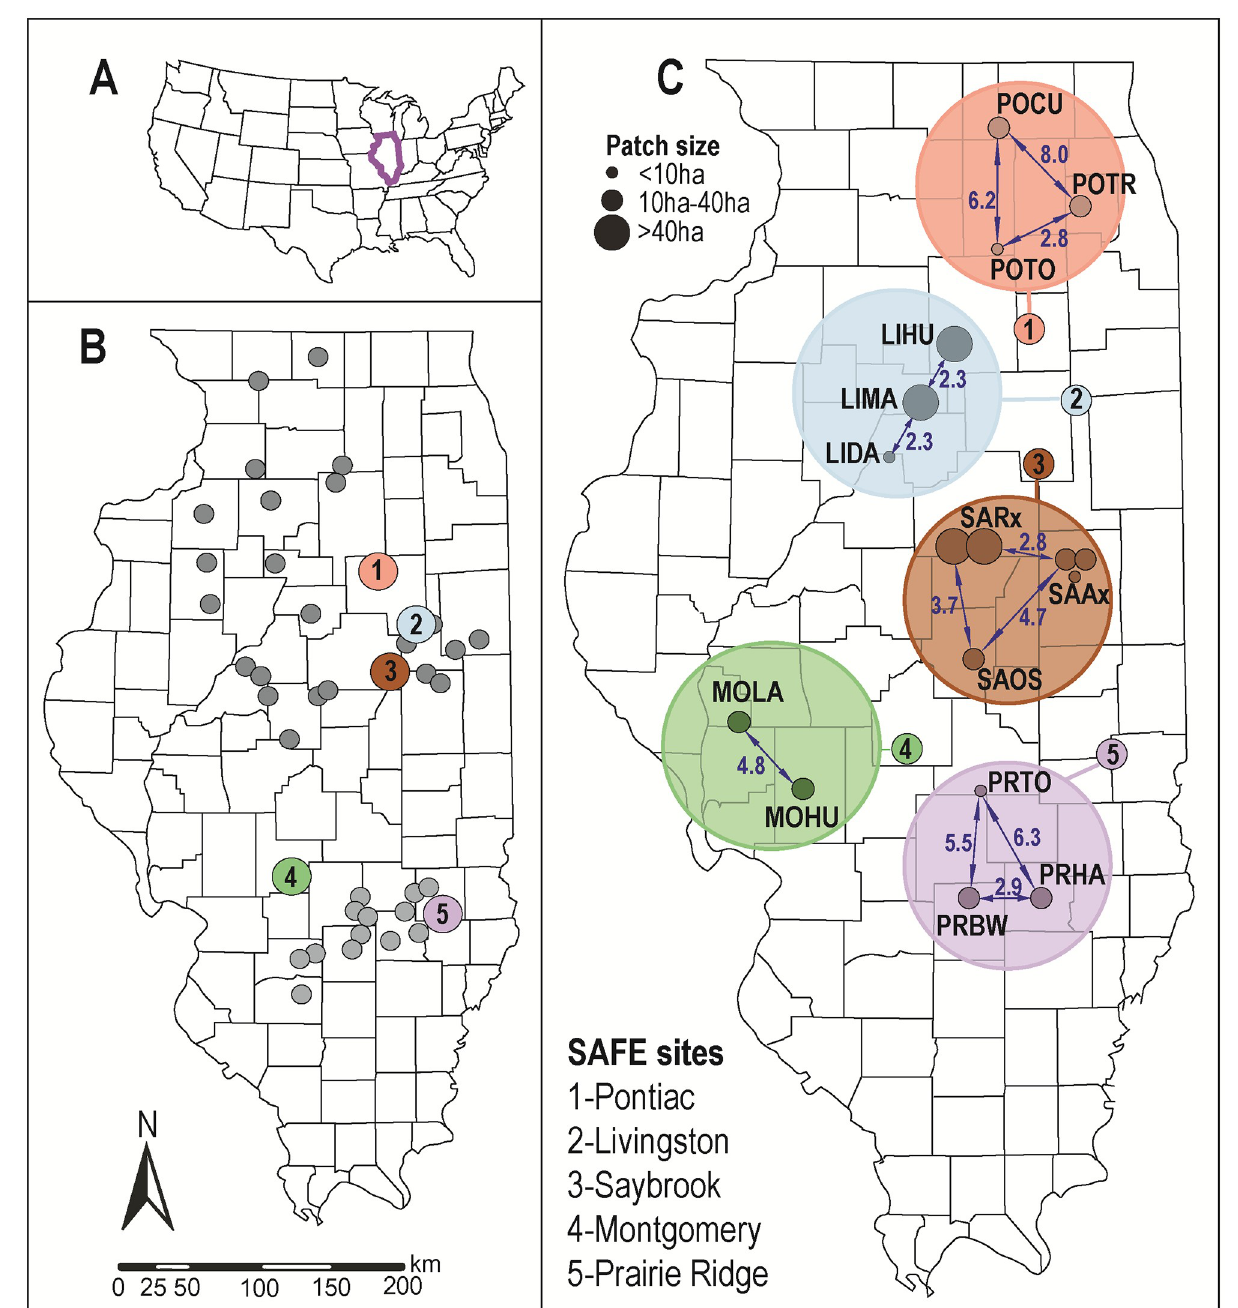
Fig 1. Map depicting State Acres for Wildlife Enhancement (SAFE) restoration sites in Illinois. (A) Location of Illinois (purple) in the USA. (B) Distribution of SAFE sites (circles) in Illinois: color = sampled sites; dark grey sites in the Grand Prairie region; light gray = sites in the Southern Till Plain. (C) Schematic distribution of restoration patches (small circles) at sampled sites (large circles): arrows = inter-patch distances (in km); circle size = patch area (in ha). The map was generated in ArcGIS 10.4.1 using publicly available data downloaded from government institutions, with boundaries derived from Topologically Integrated Geographic Encoding and Referencing (TIGER) data via U.S. Census Bureau. Additional details on patches provided in S1 Table.